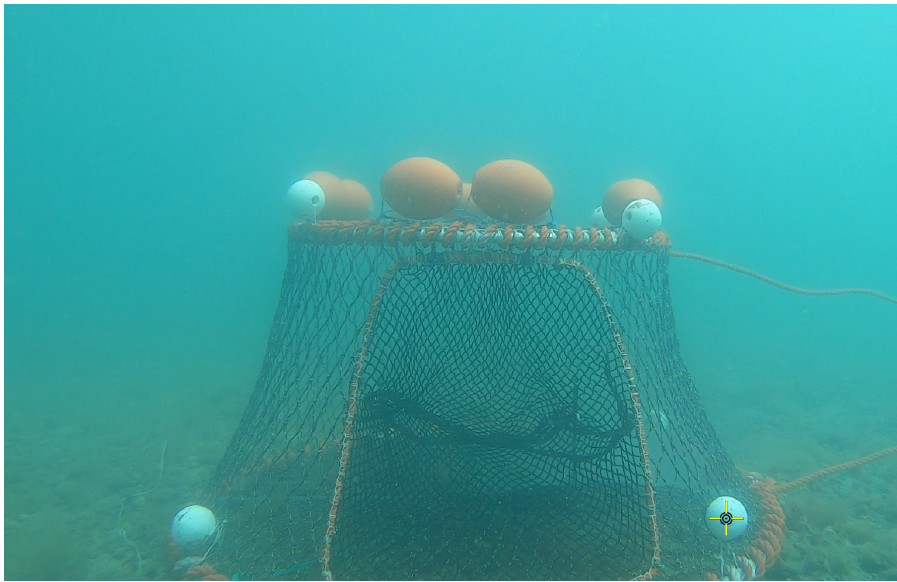
Fig 3. A heavy trap with white buoys attached to create reference points for video